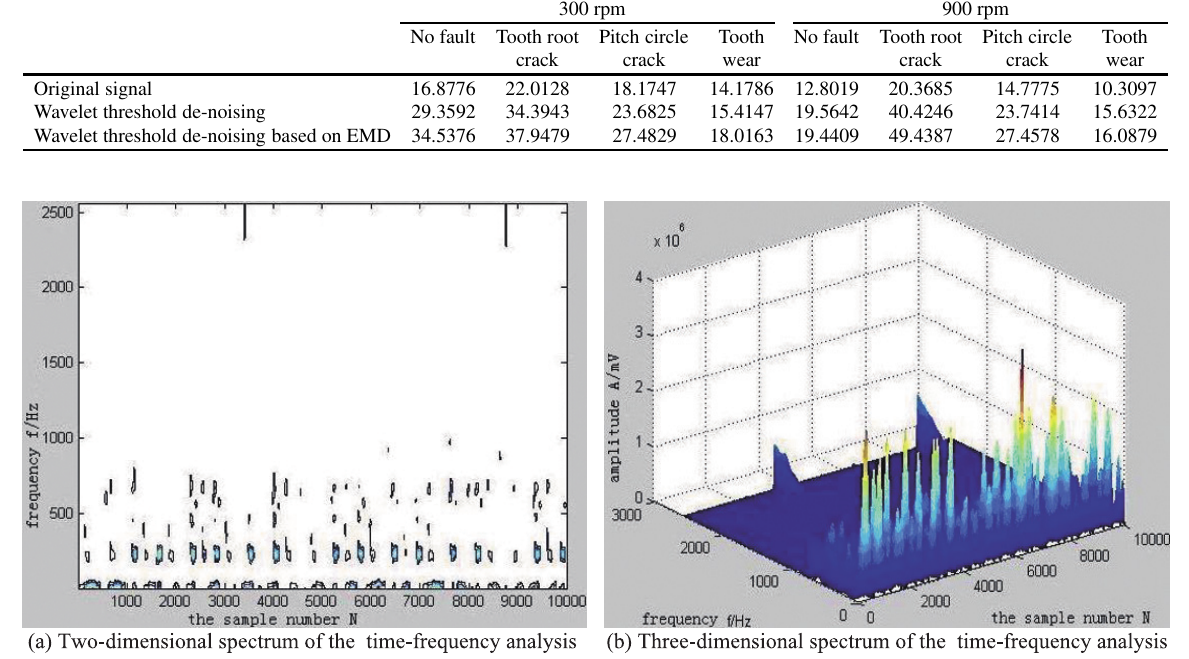
Fig. 5. The time frequency analysis of a no fault signal at 300 rpm.